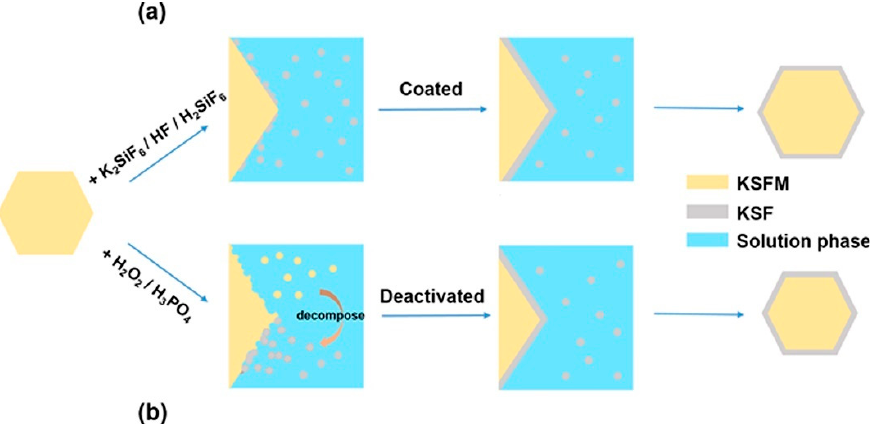
Figure 5. Design method of KSFM@KSF composites: ( a ) coated and ( b ) deactivated (Reprinted from Ref [50]. Copyright from American Chemical Society, 2018).